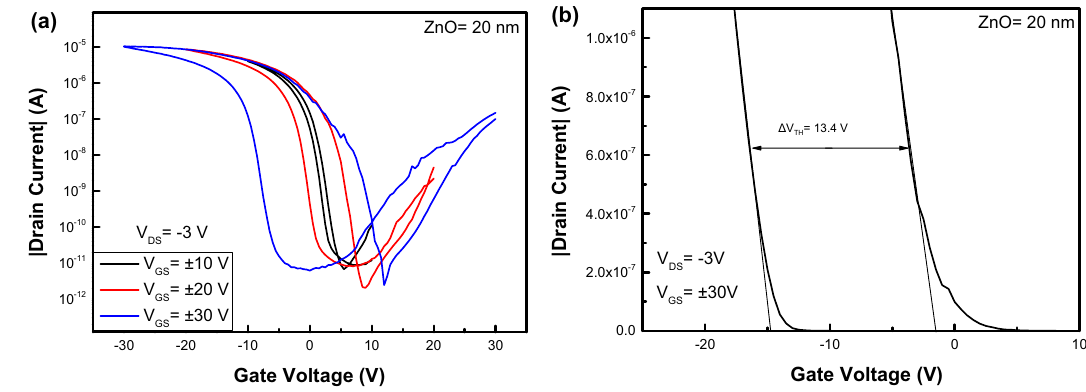
Figure 3. The transfer characteristics of pentacene OFET ( a ) in the logarithm form ( b ) in the linear form.